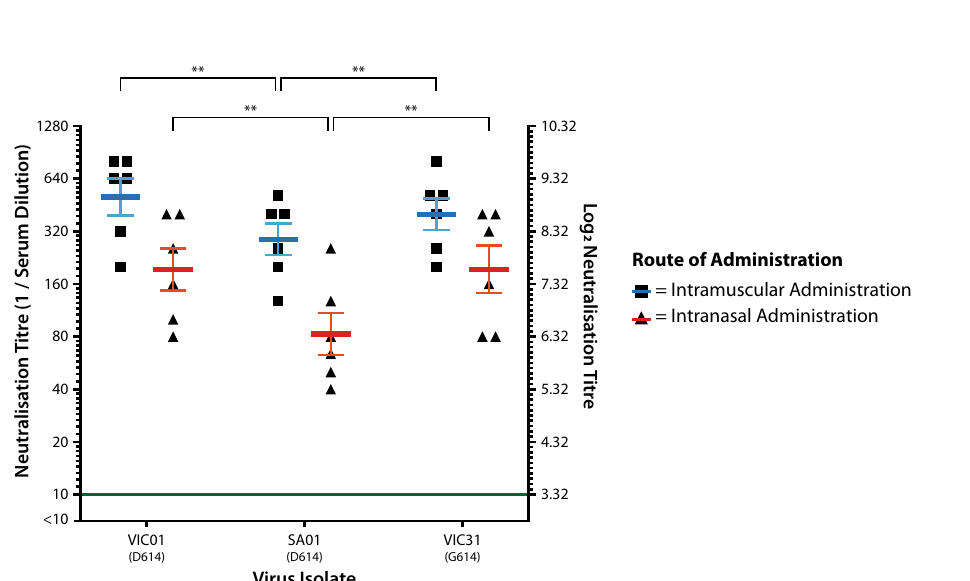
Fig. 2 Serum virus-neutralisation titres against SARS-CoV-2. Individual ferret serum samples were tested using a virus microneutralisation assay with a twofold dilution series starting at 1:10, with the neutralisation titre stated as the highest dilution of serum leading to 100% virus neutralisation. a Mean titres were calculated for each study group from log 2 -transformed data and plotted with SEM. Green vertical lines represent dates of ChAdOx1 nCoV-19 administration, whilst red vertical lines represent virus challenge at study day 28 or 56 for the two cohorts, respectively. The dark green horizontal line represents the limit of detection of the assay. b Neutralising titres for individual ferrets were presented in a heatmap with vaccine administration and challenge dates represented with green and red lines, respectively. c Integrated analysis of neutralisation titres from prime-only and prime-boost administrations. Neutralisation titres from prime-only animals were combined from study days 7, 14, 24 and 40, whilst neutralisation titres from prime-boost animals were combined from study days 35, 42, 52 and 70. These represent the same timeframe relative to the challenge date. For both intramuscular and intranasal administration of ChAdOx1 nCoV-19, the increase in neutralisation titre from a boost dose is similar, as indicated by the almost-parallel linking lines. The vertical lines with error bars represent the mean and standard error of the mean (SEM) from log 2 -transformed data.